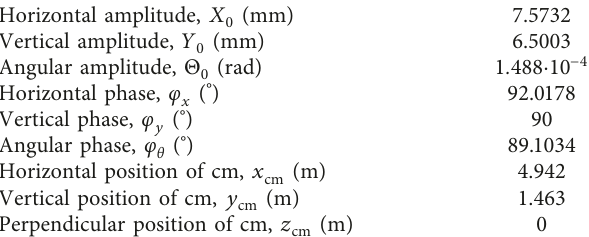
Table 2: Vibrational parameters used for DEM